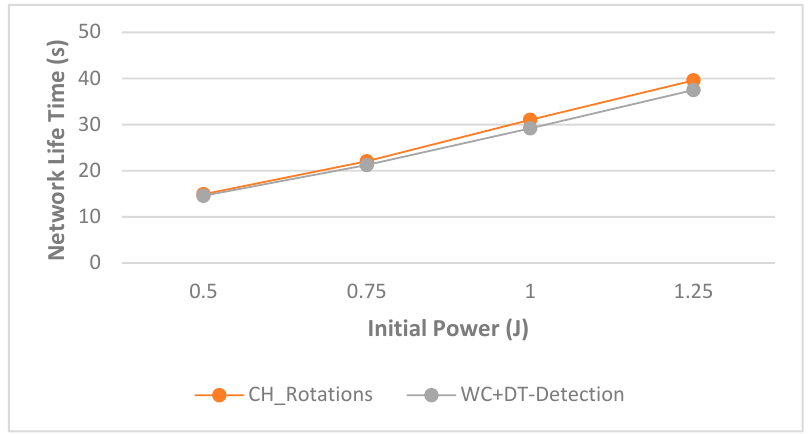
Figure 8. Analysis of the effect of WC+DT technique on WSN lifetime. This variation increased from 2% to 6% when the WSN node initial power increased from 0.5 to 1.25 J. The reason for the increase in this variance was due to the increase in the rate of packets received by the CH nodes, which in turn led to an increase in the rate of inspection and verification messages. This in turn led to an increase in the rate of power consumption within the CH nodes, and thus the result was a decrease in the network lifetime. The results show that the WC+DT detection algorithm decreased the network lifetime by 2%, 4%, 6%, and 6% compared to the WC+DT-free scenario for WSN node initial power of 0.5, 0.75, 1, and 1.25 J, respectively.